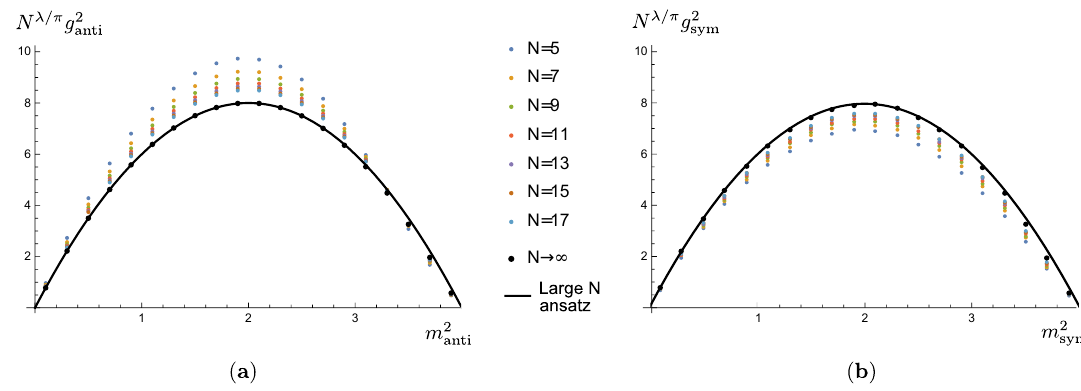
Figure 13 . Comparison between the (cid:12)nite N numerics and the large N analysis for ( a ) a single bound state in the anti-symmetric representation and ( b ) a single bound state in the symmetric representation. As discussed in the main text, both cases lead to the same maximum coupling at large N given in equation (4.16) and represented here by the solid